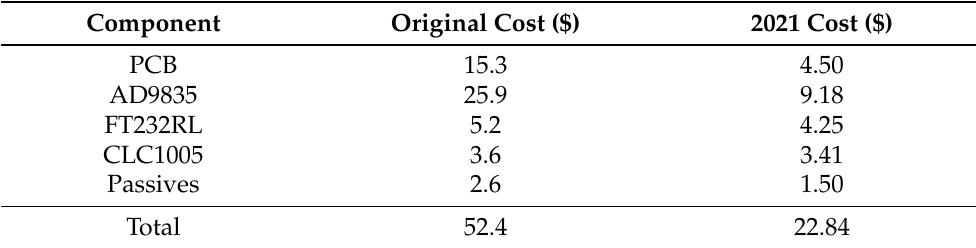
Table 4. Cost analysis of impedance spectroscopy